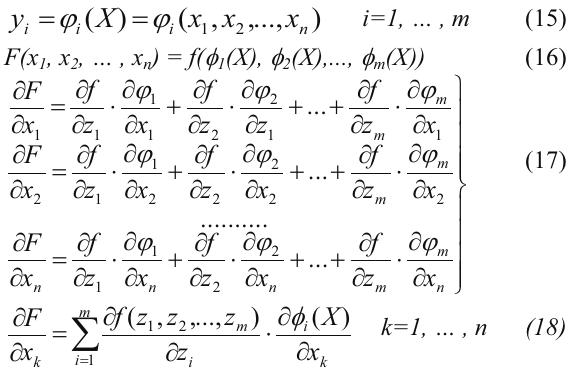
composite function derivatives with respect to the variables of previous layer blocks, are calculated